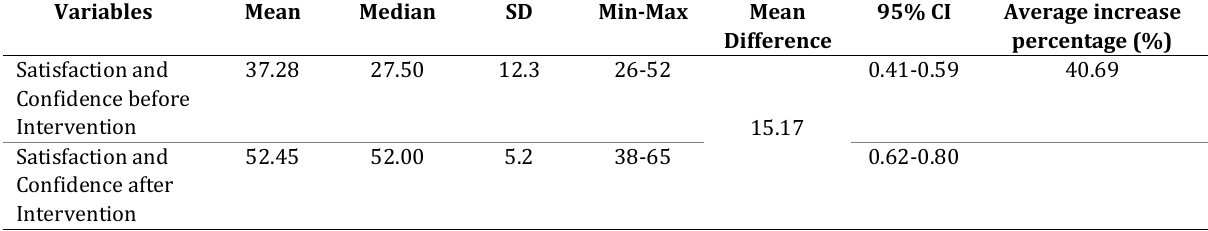
Table 2. Average Satisfaction and Confidence Before and After the Intervention (N=110) Variables